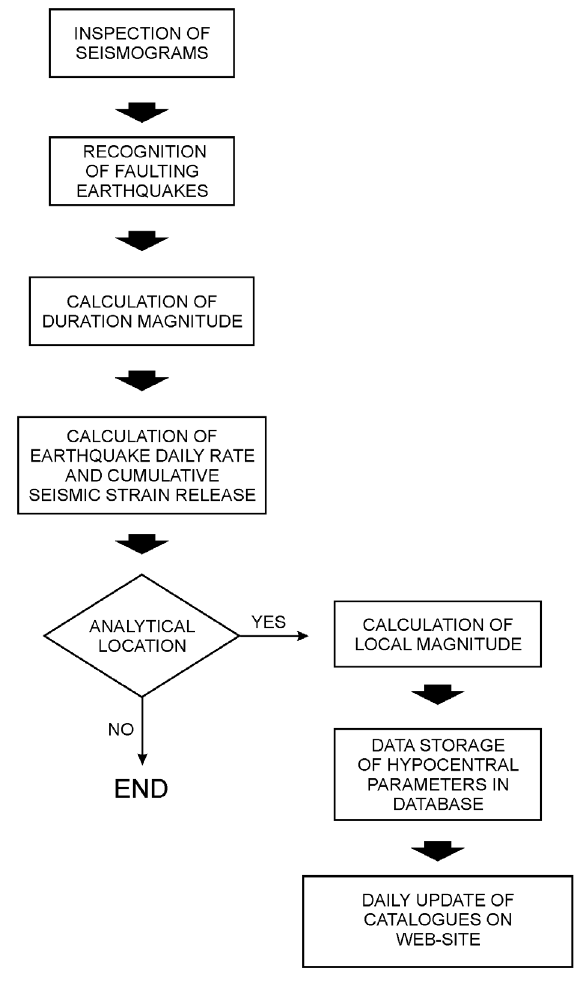
Figure 3. Flowchart of the routine analysis developed by the scien- tific staff for seismic monitoring of Mt. Etna